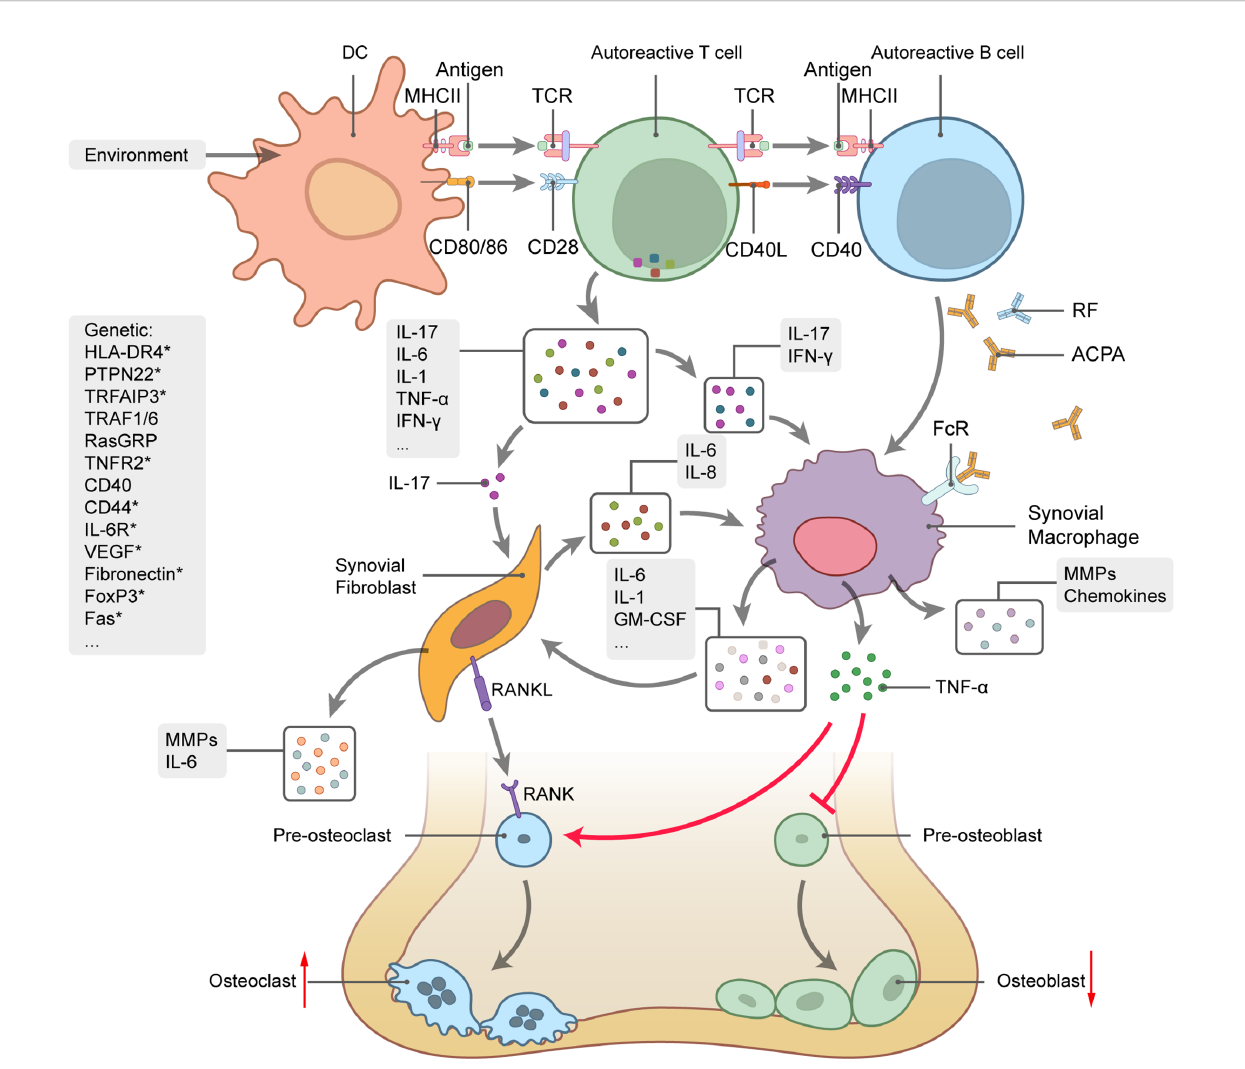
FIGURE 3 | Rheumatoid arthritis (RA) genetics and pathogenesis. Schematic picture of cytokine-mediated bone in fl ammation and destruction in RA. Genetic predisposition and environmental factors initiate the autoimmune response. Interactions between TCR and MHCII-antigen plus co-stimulation of the CD28-CD80/86 pathway trigger activation of T cells by DCs along with substantial cytokine production, B-cell activation, and autoantibody generation. IL-17 stimulates synovial fi broblast and macrophage proliferation and activation and promotes the secretion of proin fl ammatory mediators, such as TNF ‐ a , IL-1, IL-6, and GM-CSF. TNF- a regulates the balance between bone formation and destruction by promoting osteoclast precursor transformation to osteoclasts and inhibiting osteoblast precursor transformation to osteoblasts. Osteoclast differentiation also depends on the interaction between RANK and its ligand. Curved arrows represent target process activation and bar-headed lines represent target process inhibition. Straight arrows represent changes in quantity. Several RA-related genes involved in RA pathogenesis are listed on the left side of the picture. Genes with * undergo alternative